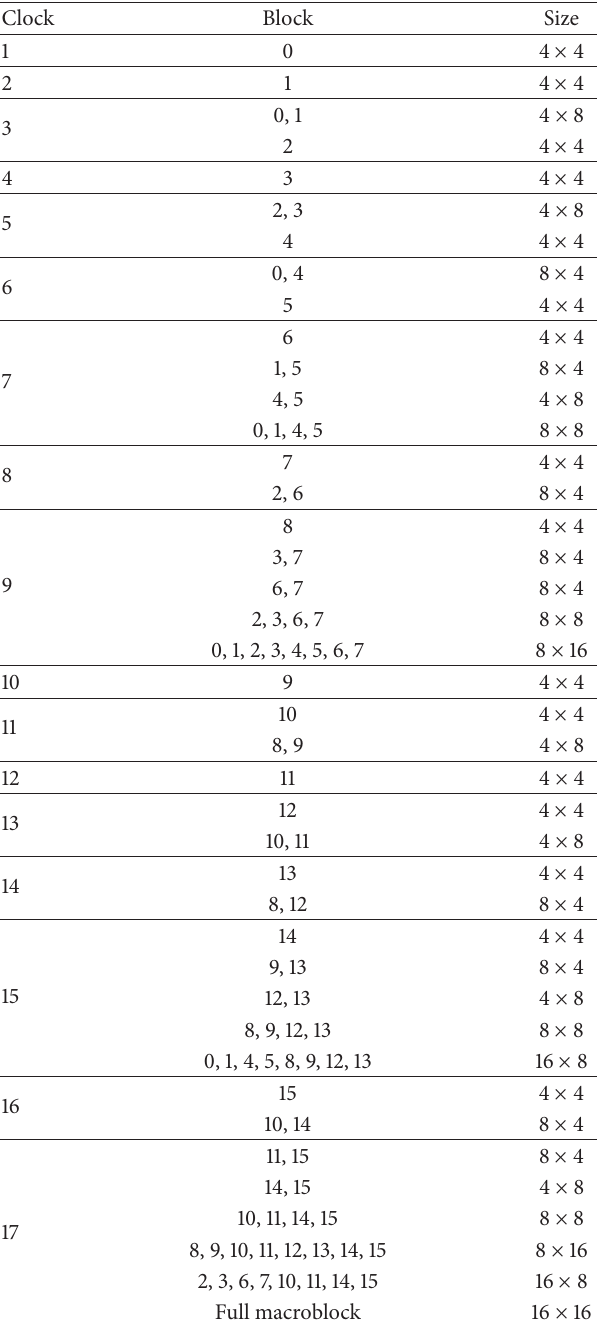
Table 2: SAD output schedule for VBSME